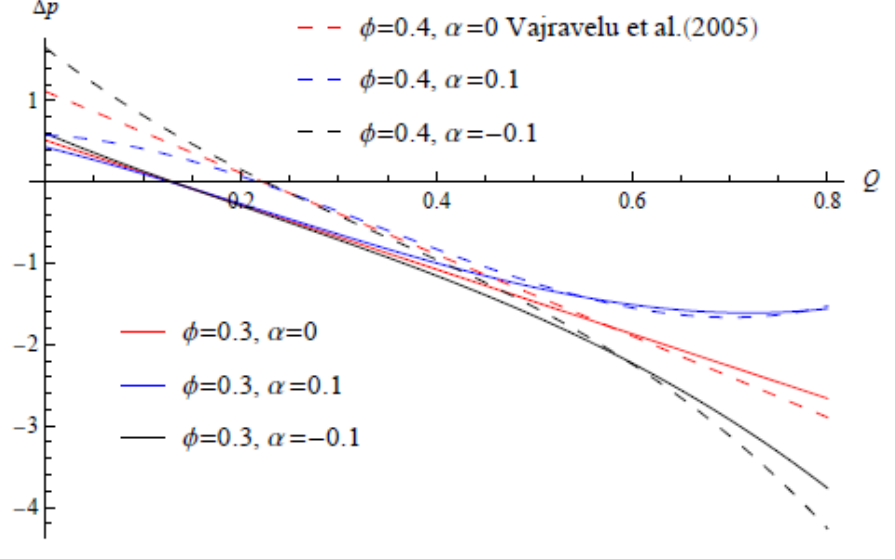
Fig. 2. Pressure rise vs. averaged flow rate for various values of ,